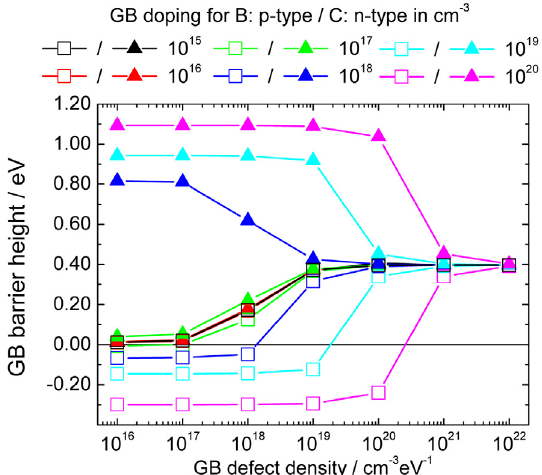
Fig. 4. Calculated potential barrier height at the interface grain-GB, in the bulk of the solar cell. The results are shown over the GB defect density (abscissae) for different GB doping concentrations (symbol slopes) and for the structures B and